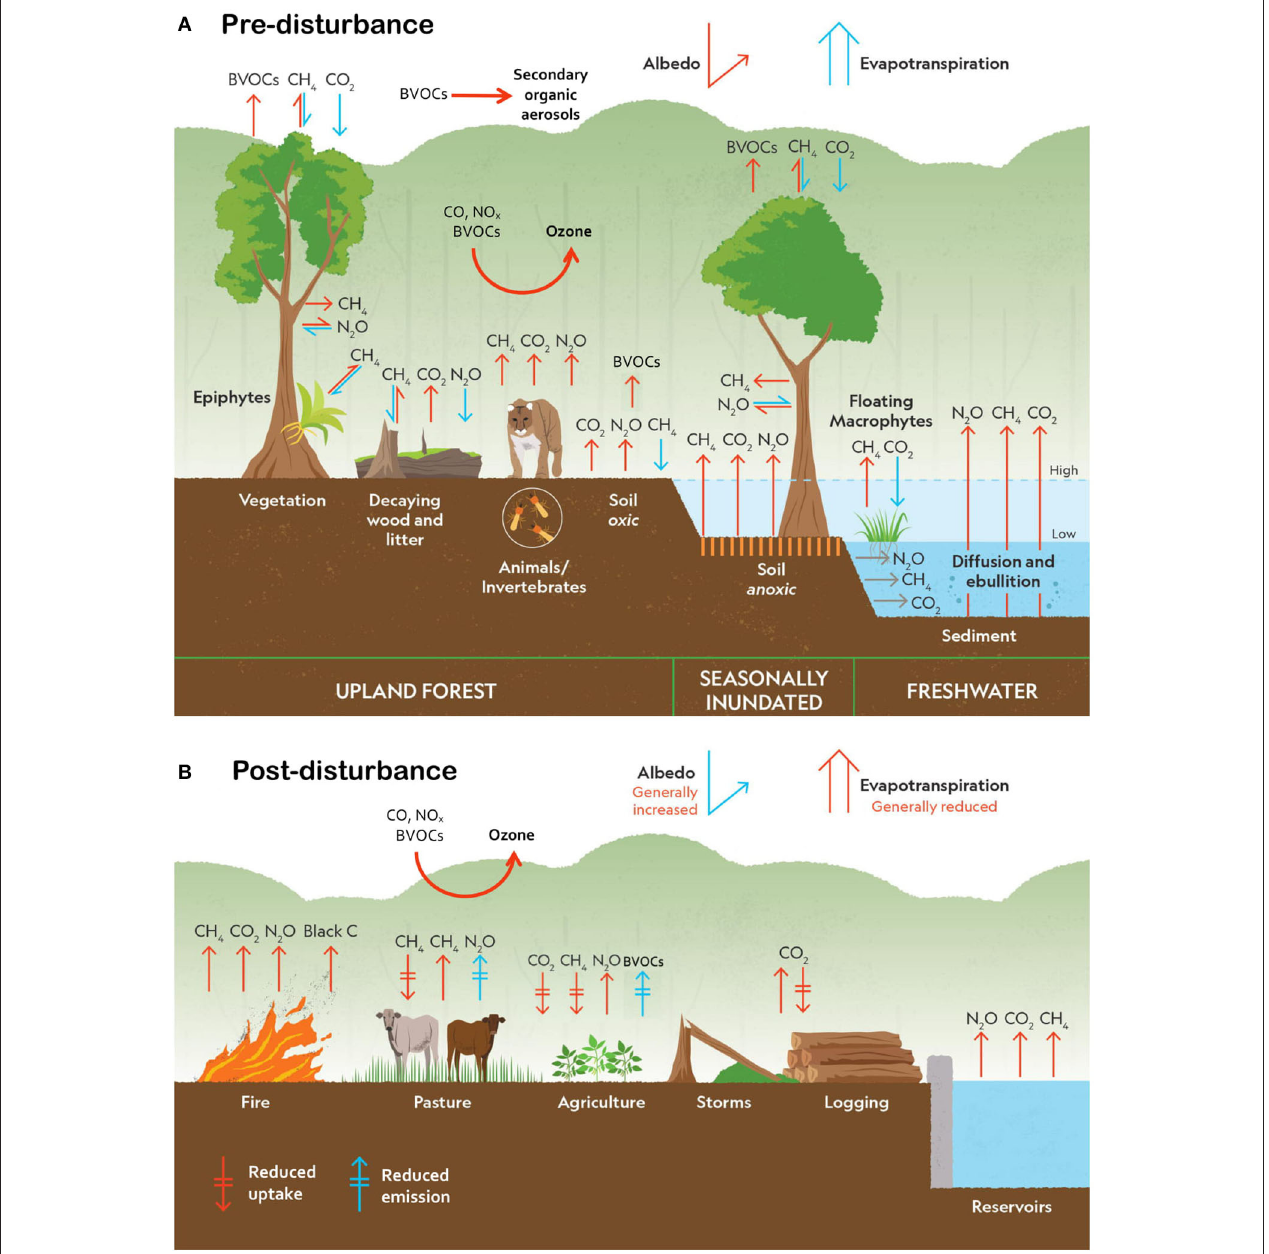
FIGURE 3 | Local-scale (A) pre-disturbance and (B) post-disturbance fluxes, biophysical forcing agents, and their associated short-term radiative forcing impact (positive, red; negative, blue; hashed arrows indicate a reduction in—as opposed to directional change to—a flux following disturbance) from undisturbed upland forests, seasonally inundated forests and wetlands, and freshwater ecosystems of the Amazon Basin. Note that because the magnitude of many of these effects is not well-defined, the arrow length is not proportional to source/sink strength.